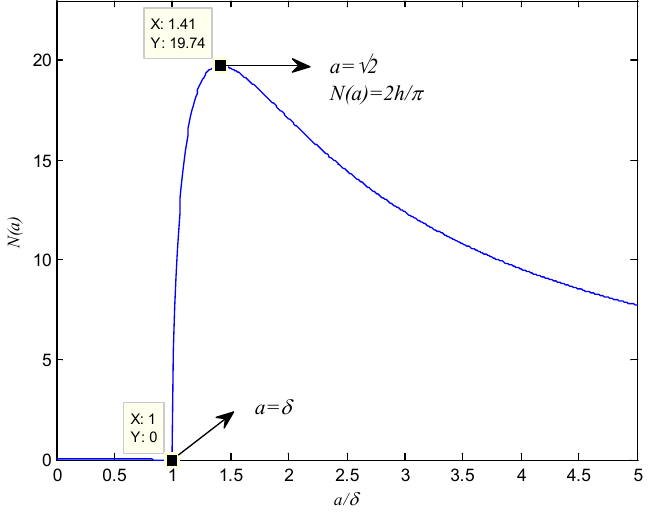
Figure 21. Graphical illustration of Describing Function(DF) (relay with dead zone) against with 𝑎 𝛿⁄ ℎ = 𝜋